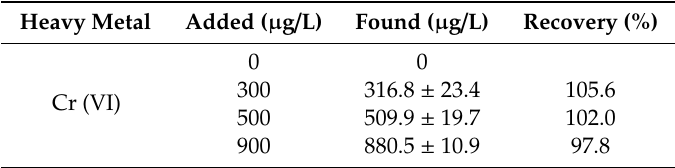
Table 2. Recovery result for Cr (VI) in real water sample.